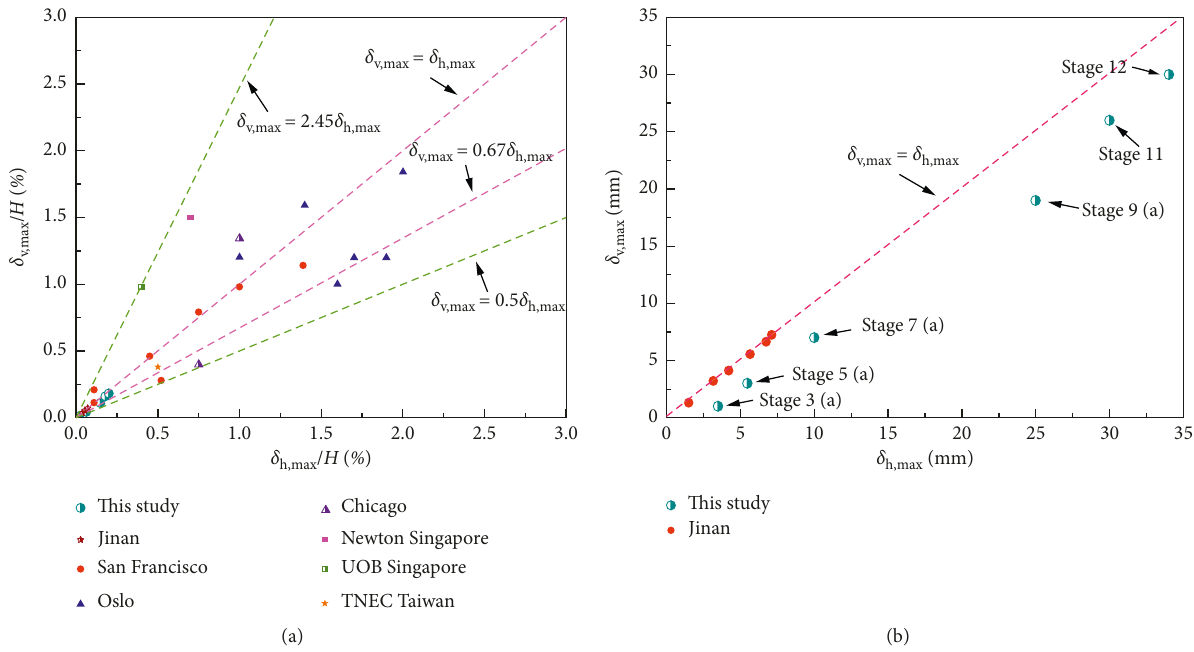
Figure 15: Relationship between the maximum ground settlement and the maximum piles deflection. (a) Combined cases date. (b) This